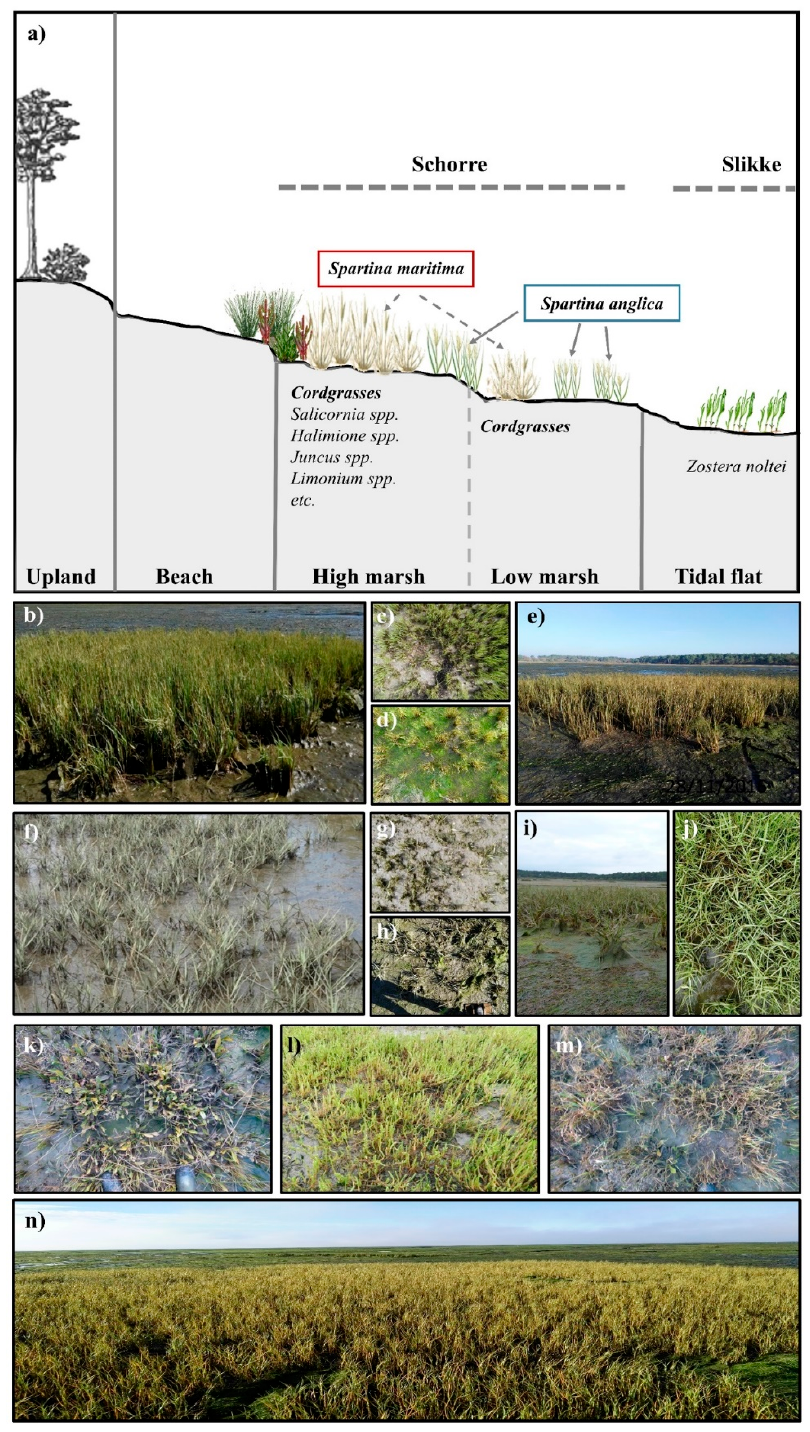
Figure 2. Characterization of vegetation in the Bay of Arcachon. ( a ) Schematic representation of the typical distribution of intertidal vegetation along the tidal gradient; ( b ) dense green meadow of Spartina maritima ; ( c ) transition from a dense to a sparse Spartina maritima meadow; ( d ) Spartina maritima with homogenous seaweed ( Ulva ) coverage; e) brownish dense meadow of Spartina maritima ; ( f) sparse green meadow of Spartina anglica ; ( g ) sparse withered meadow of Spartina anglica ; ( h , i ) Spartina anglica with thick algae coverage; ( j ) dense green meadow of Spartina anglica; ( k ) Halimione ; ( l ) Salicornia ; ( m ) mix of diverse vegetation; and ( n ) dense Spartina maritima meadow with vegetated tidal flat, both due to well-developed Zostera noltei meadows and a strong presence of algae deposits in the background.